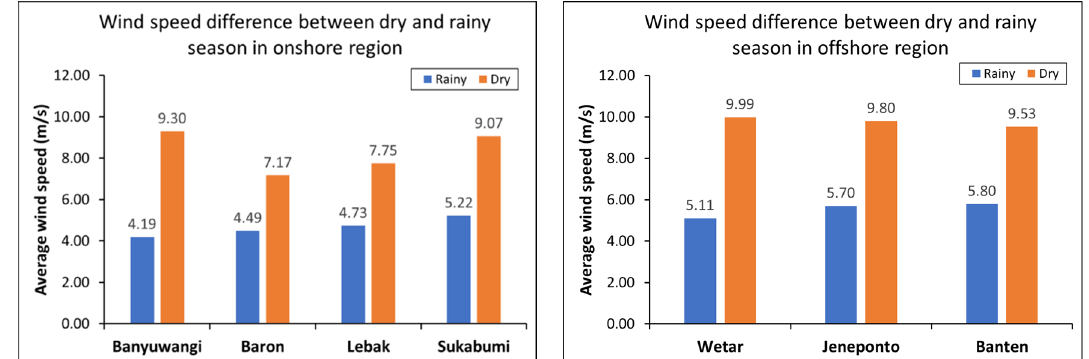
Figure 2. Average wind speed (2004–2015) for dry and rainy seasons in onshore ( left ) and offshore ( right ) sites.